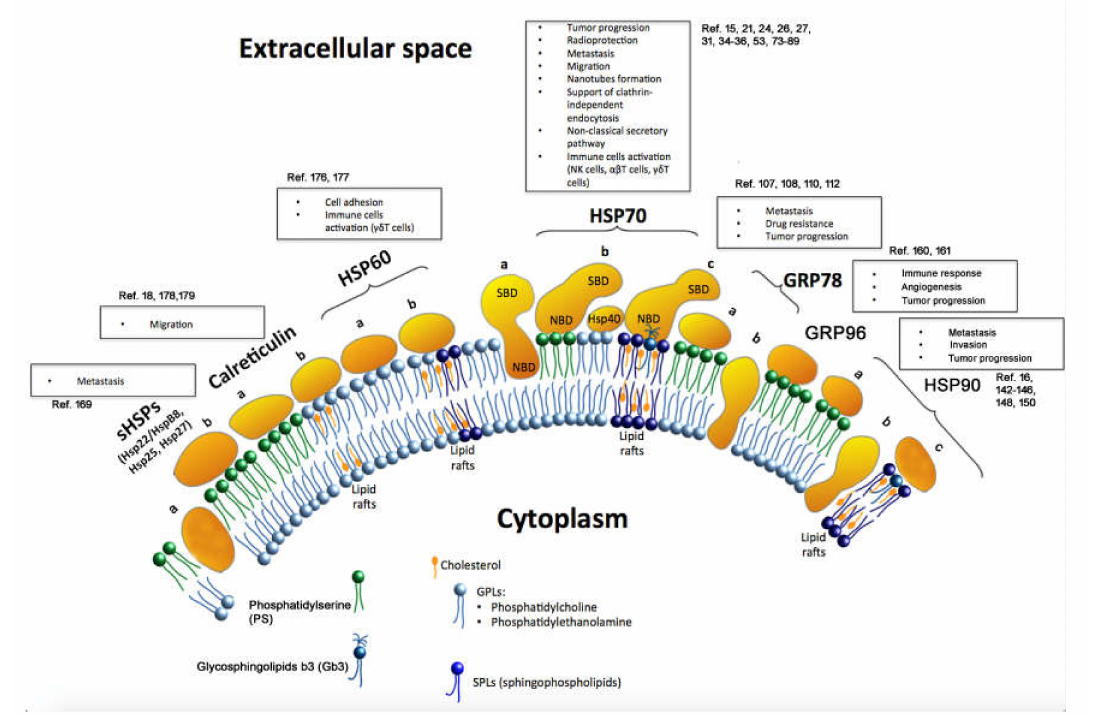
Figure 1. Membrane-associated heat shock proteins and their role in tumor